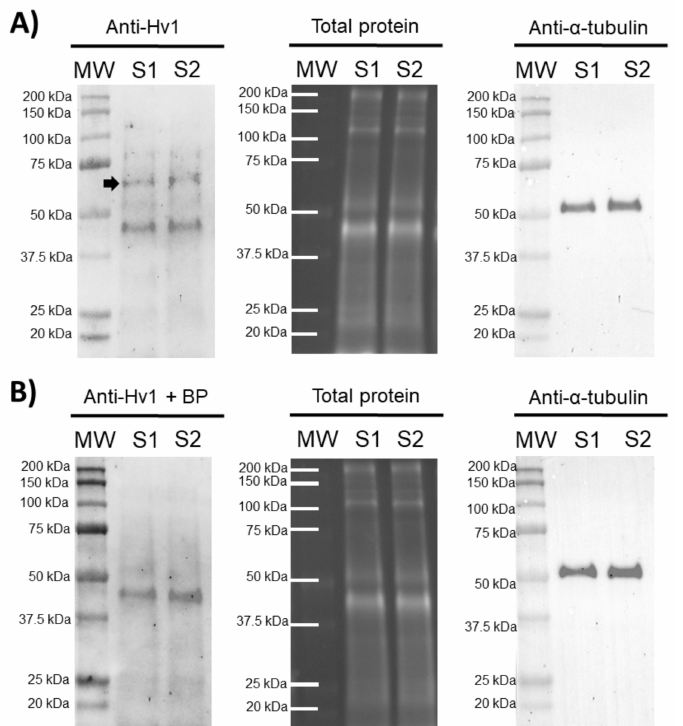
Figure 1. Representative immunoblots for HVCN1 channel. ( A ) Anti-Hv1 in two pig sperm samples (S1 and S2), and its corresponding peptide competition assay; ( B ) Anti-Hv1 + BP. The arrow indicates the HVCN1-specific band of 70 kDa. TGX ™ Stain Free (Total protein) and α -tubulin (Anti- α -tubulin) were performed as loading